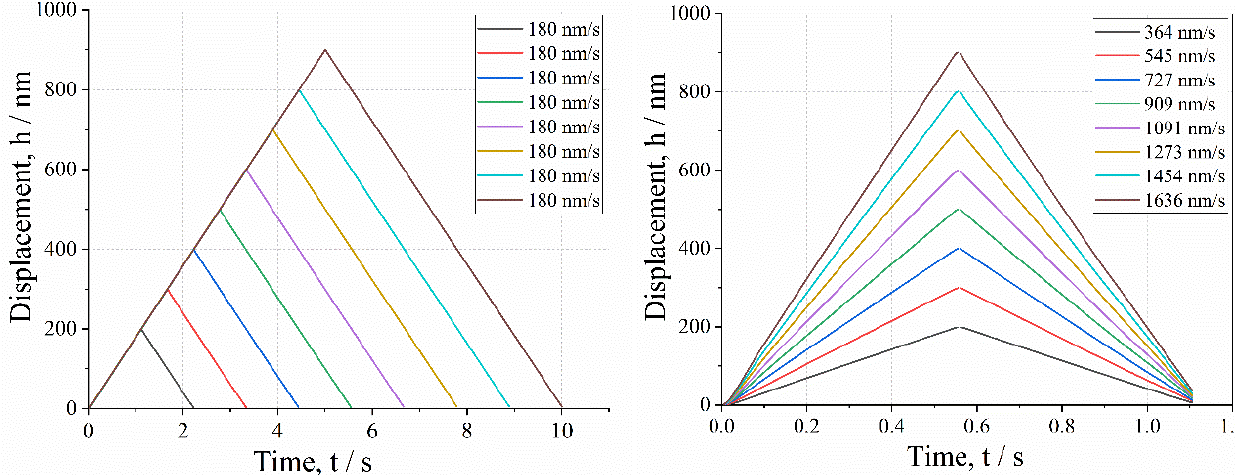
Figure 2. Displacement functions of applied modes: constant displacement rate ( left ) and constant segment time ( right